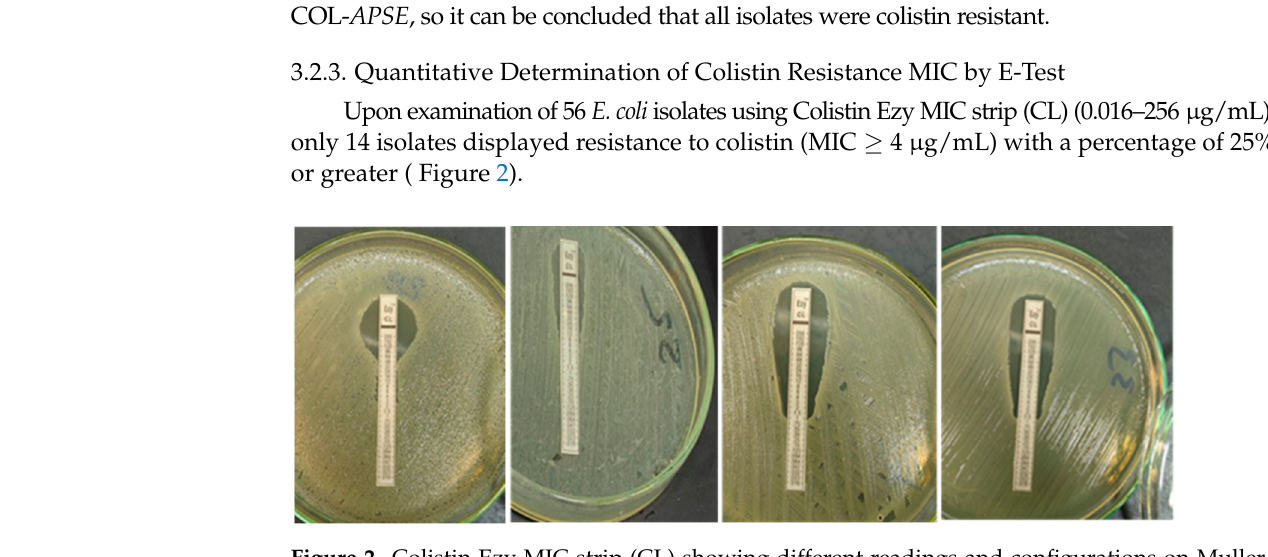
Figure 2. Colistin Ezy MIC strip (CL) showing different readings and configurations on Muller– Hinton agar plates.